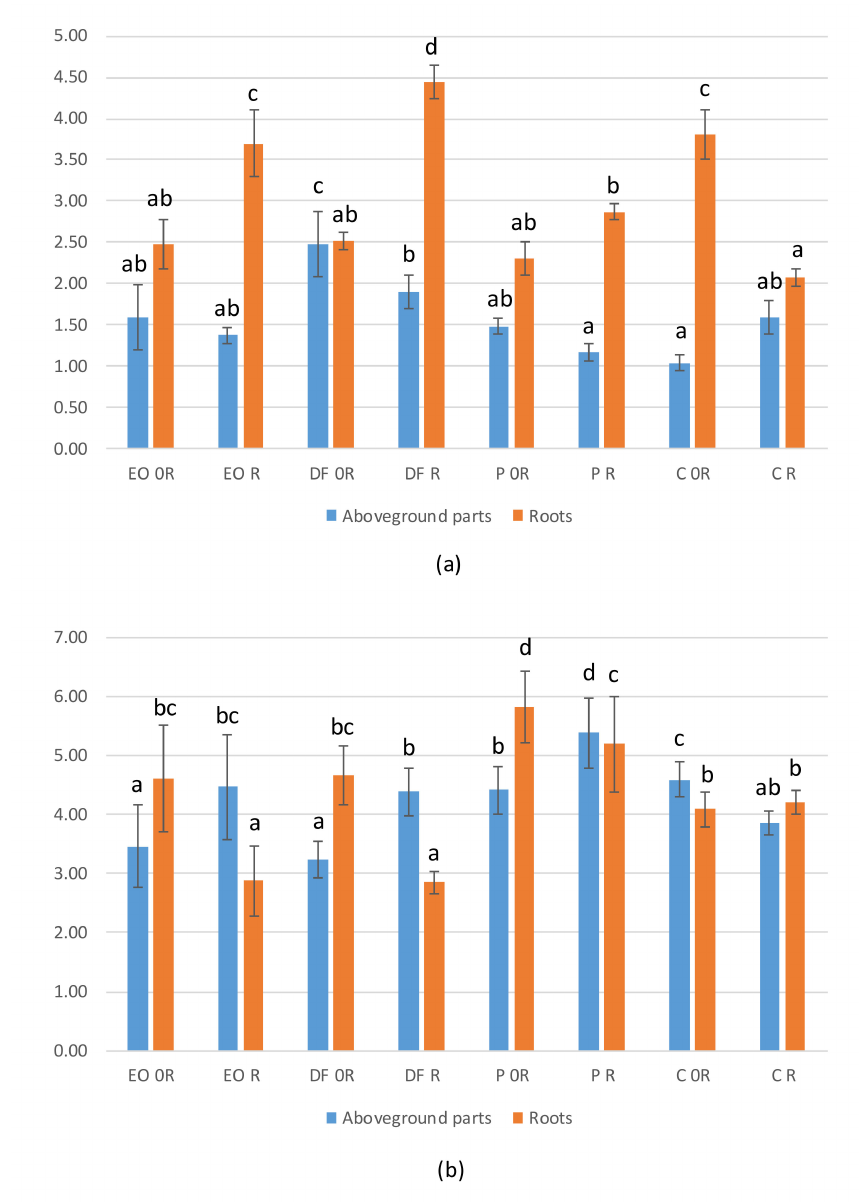
Figure 1. The e ff ect of petroleum-derived substances and bioremediation on the ratio of nutrients in Vicia faba L. ( a ) K / (Ca + Mg); ( b ) Ca / Mg. Symbols as in Table 1. Means ( ± SE) marked with the same letters (separately for the aboveground parts and roots) do not di ff er significantly according to the LSD test at p <